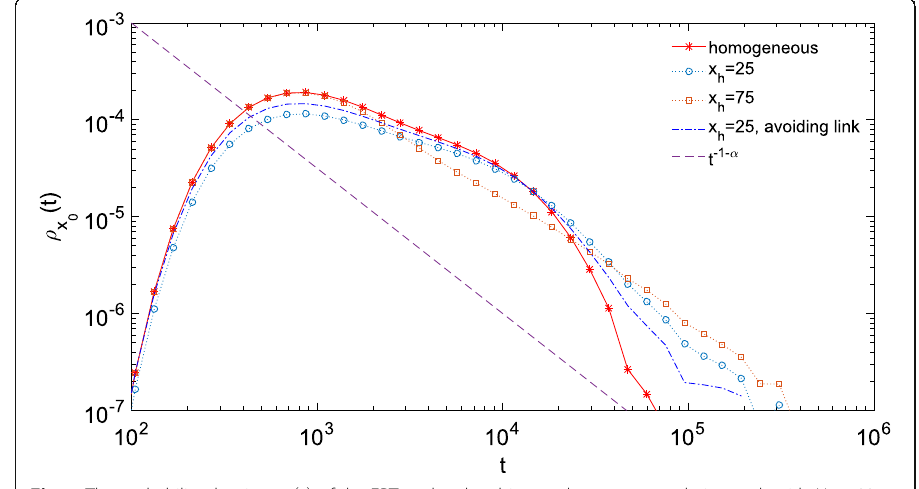
ð t Þ of the FPT to the absorbing node x N =100 Fig. 1 The probability density ρ x a =1 on a chain graph with 0 nodes with the reflecting node at x=100. Travel time distributions are fixed to be ~ ψ xx 0 ð s Þ ¼ 1 = ð s τ þ 1 Þ ð s Þ ¼ 1 with τ = 1 in all nodes x except the trap node x h located either at 25, or at 75, at which ~ ψ x h x 0 = ð s a τ a þ 1 Þ ; a = 0.5. The starting point is located at x 0 = 50. The additional link is placed around the trap x h =